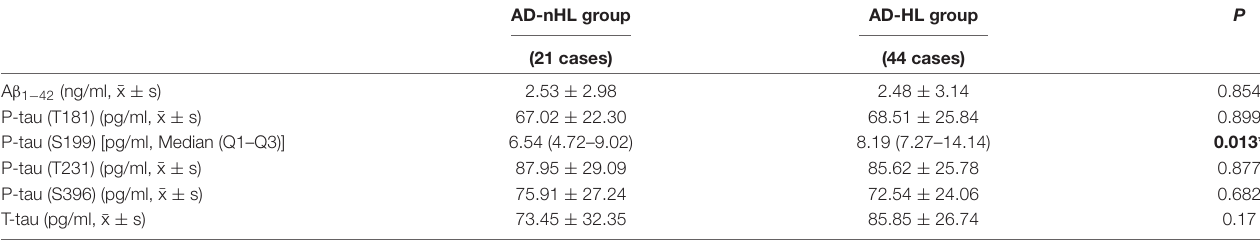
TABLE 4 | Levels of neuropathological biomarkers of AD in cerebrospinal fluid (CSF) from AD-nHL and AD-HL